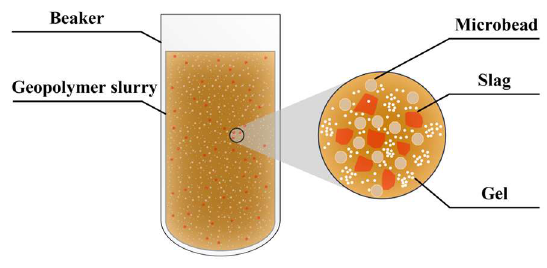
Figure 18. Micro-bead effect.